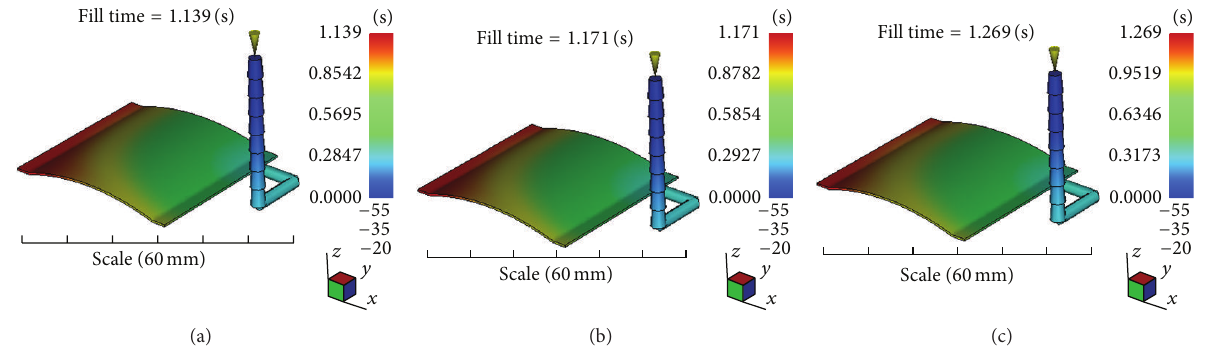
Figure 3: Fill times for (a) PP, (b) PP + 10 wt% glass fibre, and (c) PP + 50 wt% wood.